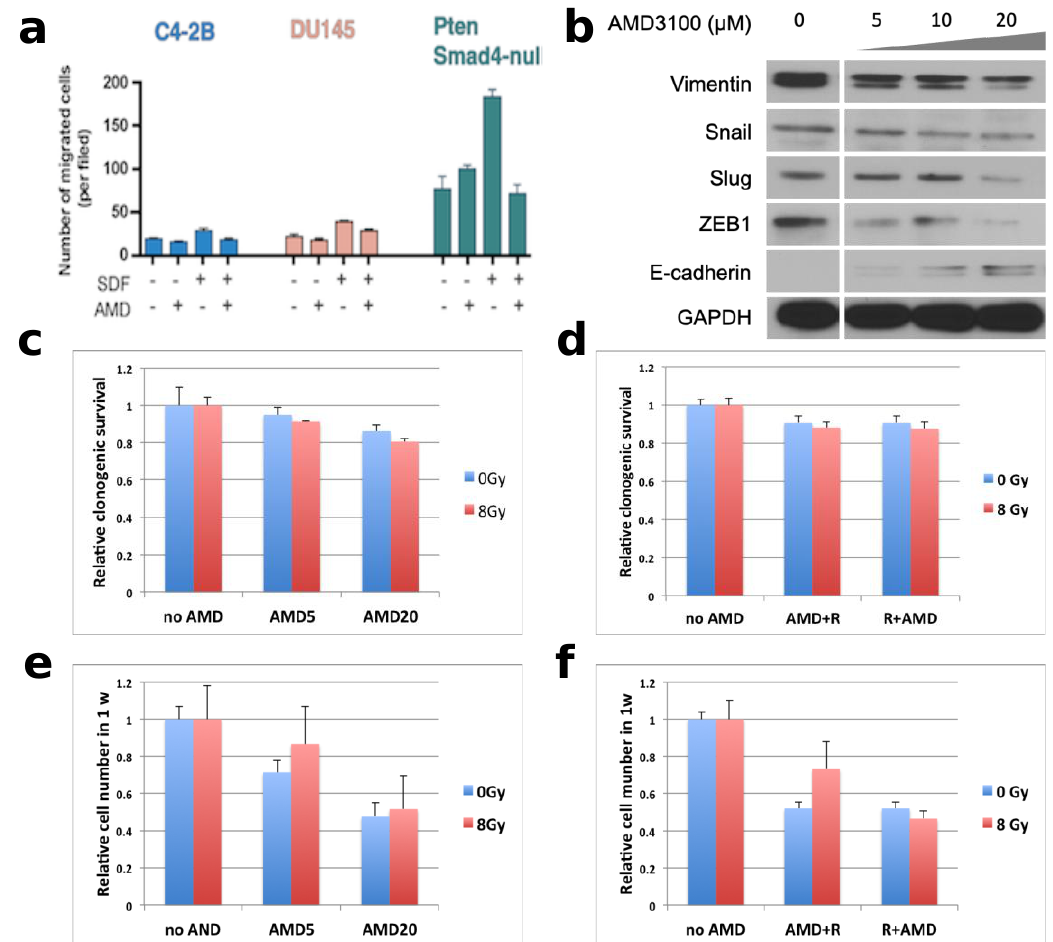
Figure 2. Effects of CXCR4 inhibition with AMD3100 (AMD) on PCa cell migration, expression of EMT-related genes, and radiosensitivity in vitro. ( a ) AMD3100 inhibited PCa cells’ migration, with or without stimulation with rSDF1 α . ( b ) Changes in markers associated with EMT in PtenSmad4 -null murine PCa cells following CXCR4 inhibition with AMD using concentrations between 5–20 µM. ( c – f ) Effects of AMD3100 (5 or 20 µM) on clonogenic survival ( c , d ) and the total number of viable cells ( e , f ) treated with and without irradiation at a dose of 8 Gy (which decreased clonogenic survival by 13% compared to control); colonies were stained and analyzed 1 week after treatment initiation. AMD was administered at concentrations of 5 and 20 µ M 1 hr before irradiation ( c , e ) and at a concentration of 20 µ M 10 min after irradiation ( d , f